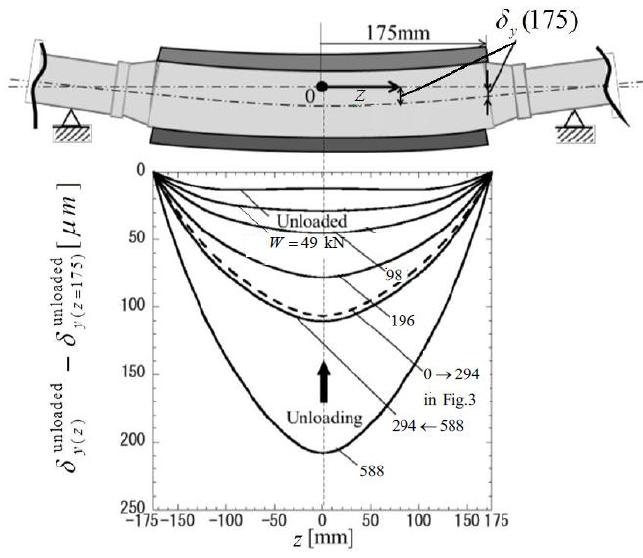
Figure 10. Deflection and residual deflection on arbor when load was reduced from 588 kN ( μ = 0.5).